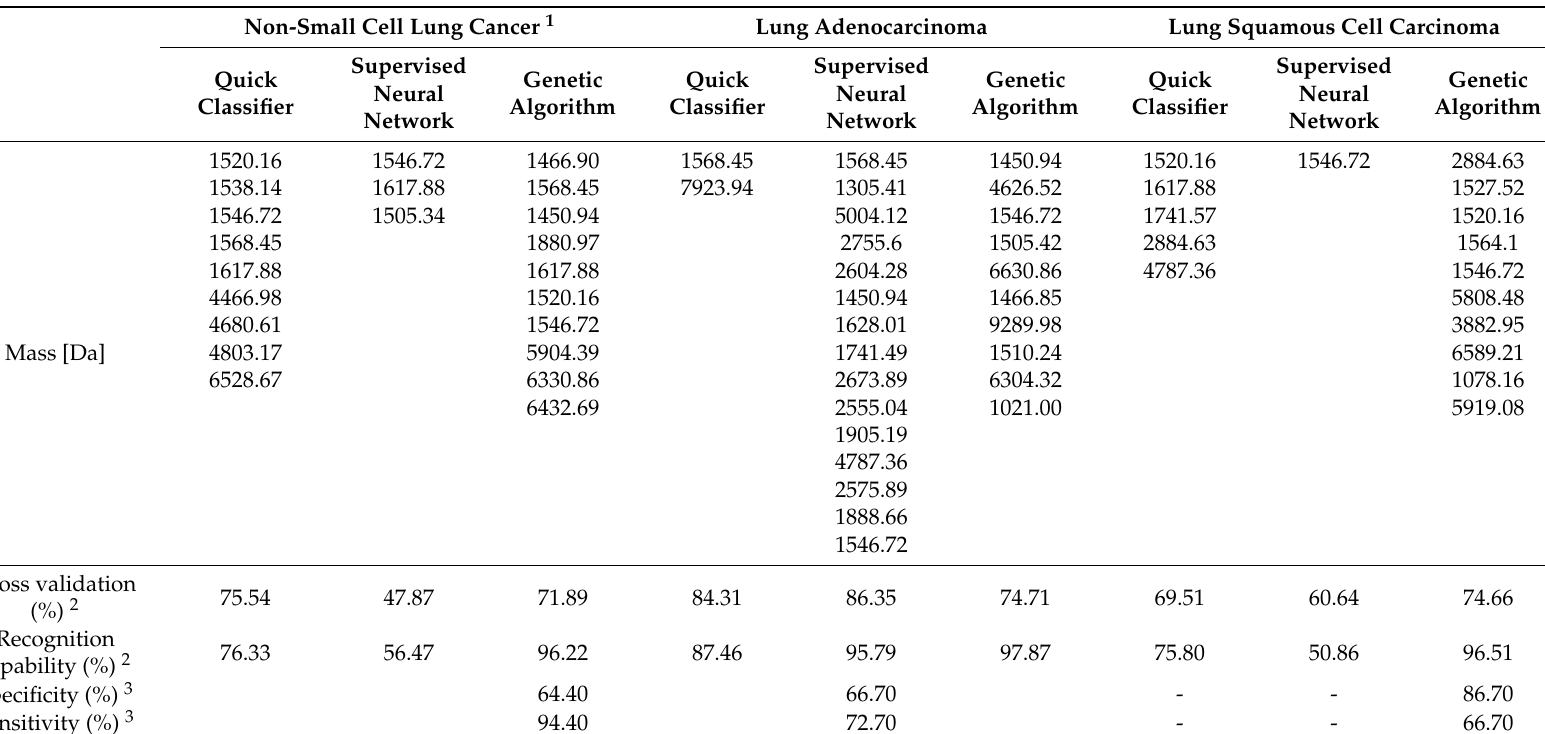
Table 3. List of peptide ions included to the generated classification models and diagnostic performances of the